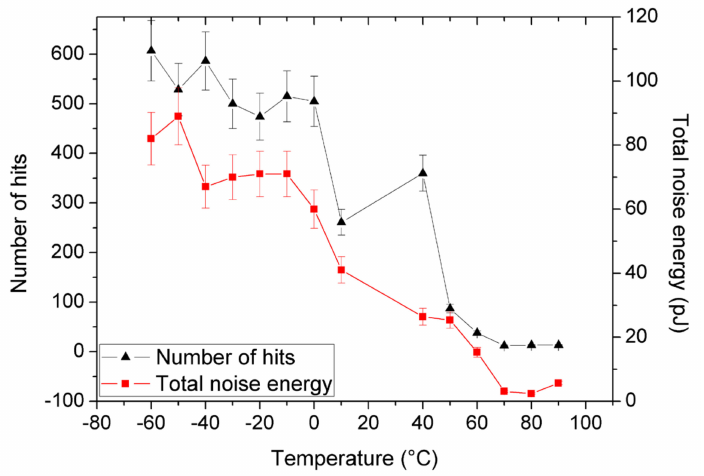
Figure 3. Temperature dependence of the total number of acoustic events and the total noise